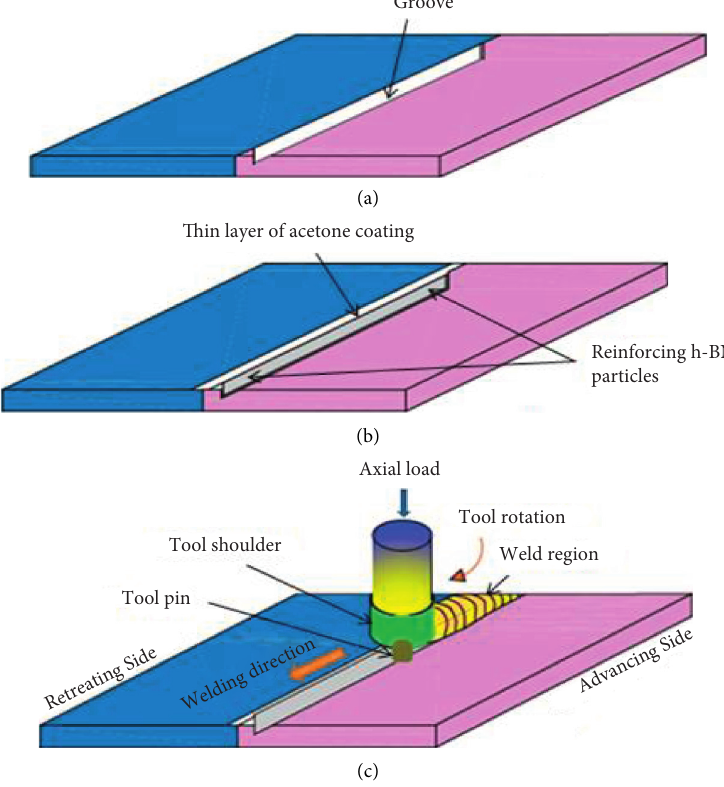
Figure 3: Schematic depiction of FSW process procedure. (a) Groove along the faying surface of the base alloys, (b) compaction of the reinforcing particles, and (c) FSW principle.